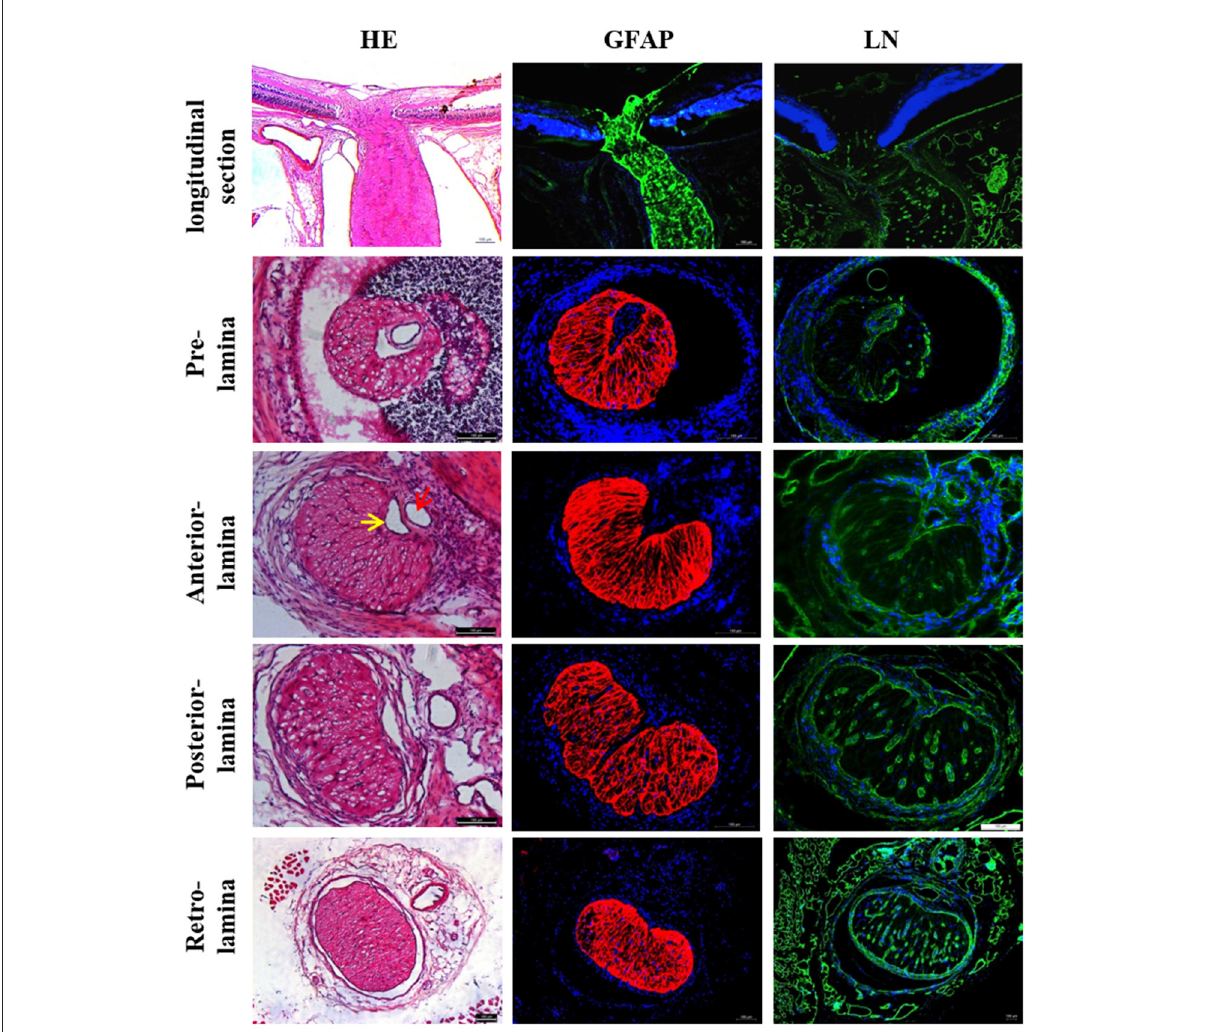
FIGURE1 Histological characteristics of rat LC. LC was located in the front of the optic nerve, which narrowed like a “bottle neck.” Rat LC exhibited a well-developed lamellar structure and positive staining against GFAP and LN. CRA (red arrow) and CRV (yellow arrow) are closely adjacent in the laminar region. The lumen of CRA was nearly round, whereas the lumen of CRV had a triangular or crescentiform configuration. LC, Lamina cribrosa; GFAP, Glial fibrillar acid protein; LN, Laminin; CRA, Central retinal artery and vein; CRV, Central retinal